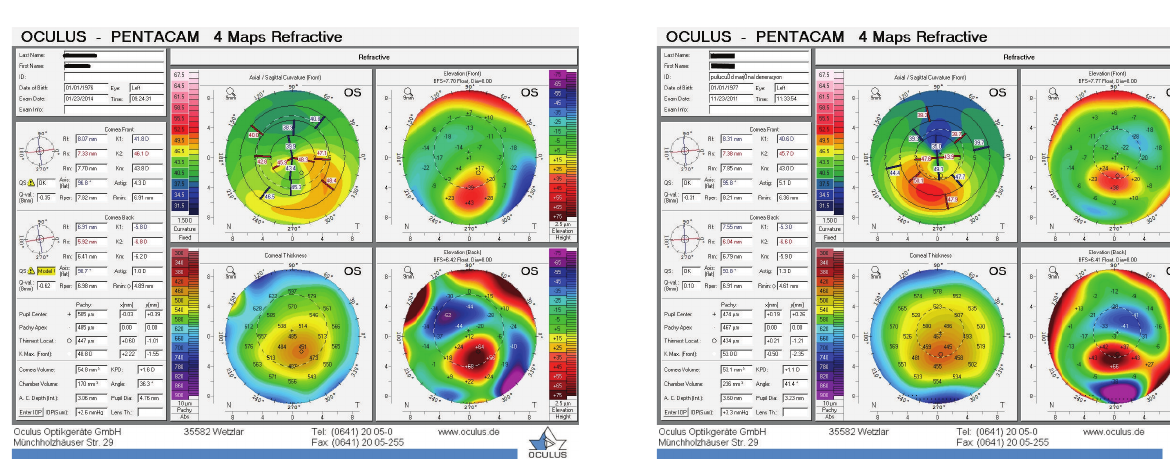
Figure 4: Patient 1, left eye at the last visit.